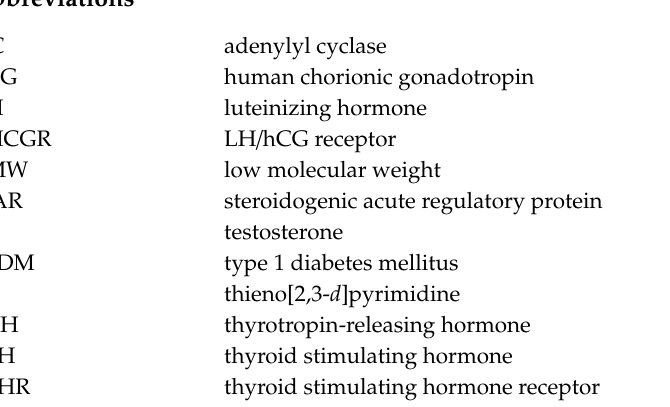
Table S5: The list of the primers for the investigated and the reference genes in real-time PCR